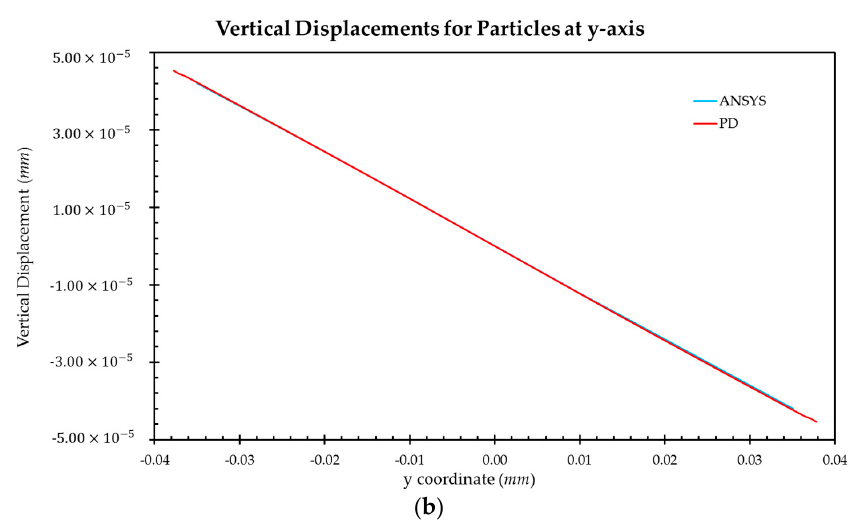
Figure 8. Comparison of displacements between FEM and PD analyses for Nb Crystal for 45° orientation: ( a ) horizontal displacements for particles along the central x-axis; ( b ) vertical displacements for particles along the central y-axis.